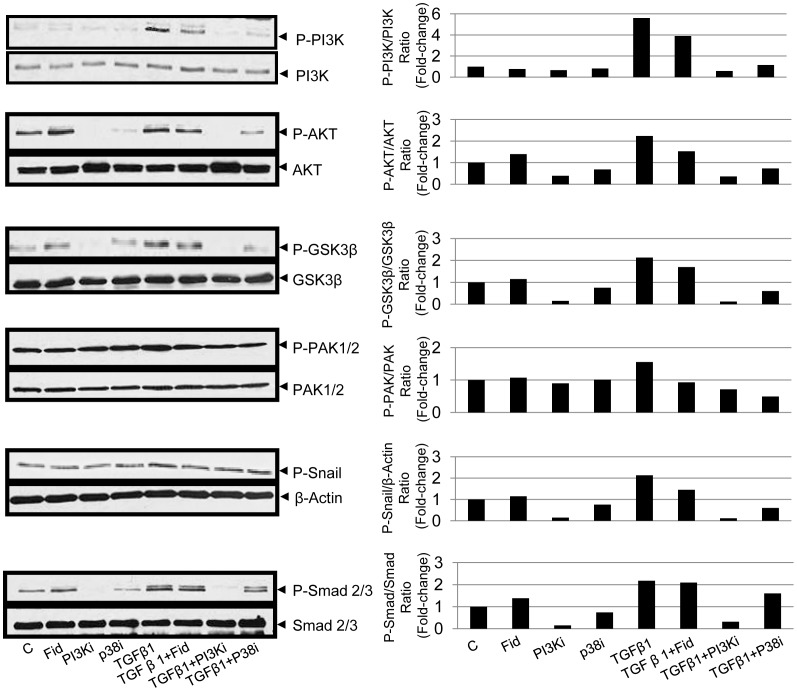
AR inhibition prevents TGFβ1-induced phosphorylation of PI3K/AKT and GSK3β and other signaling intermediates in SAECs.The SAECs were seeded in 6-well plate and starved for overnight with or without fidarestat and stimulated with TGFβ1 and incubated for 1 h. At the end of incubation period cells were washed with cold PBS and cell lysate was subjected to Western blotting using antibodies against phosphorylated-PI3K, AKT-1/2/3, GSK3β, PAK-1/2/, Snail and Smad2/3 to assess the activation of signaling kinases. A representative blot with respecitve densitometry data (bar diagram) is shown (n = 4). C, control, Fid, fidarestat, PI3Ki, PI3K inhibitor, TGFβ1, transforming growth factor-beta 1, P38i, P38 inhibitor.